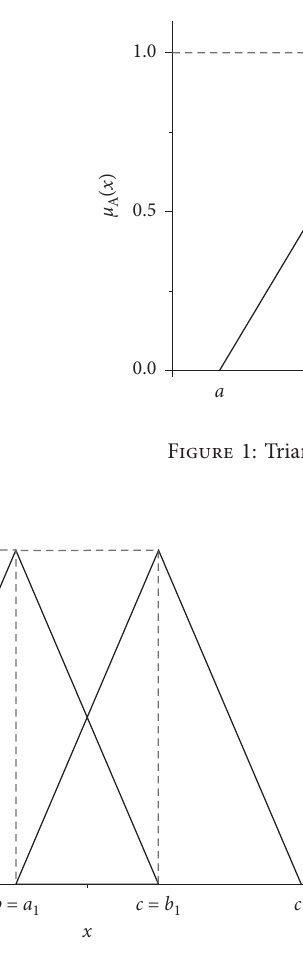
Figure 2: Overlapping of fuzzy triangular numbers ( a , b , c ) and ( a 1, b 1, c